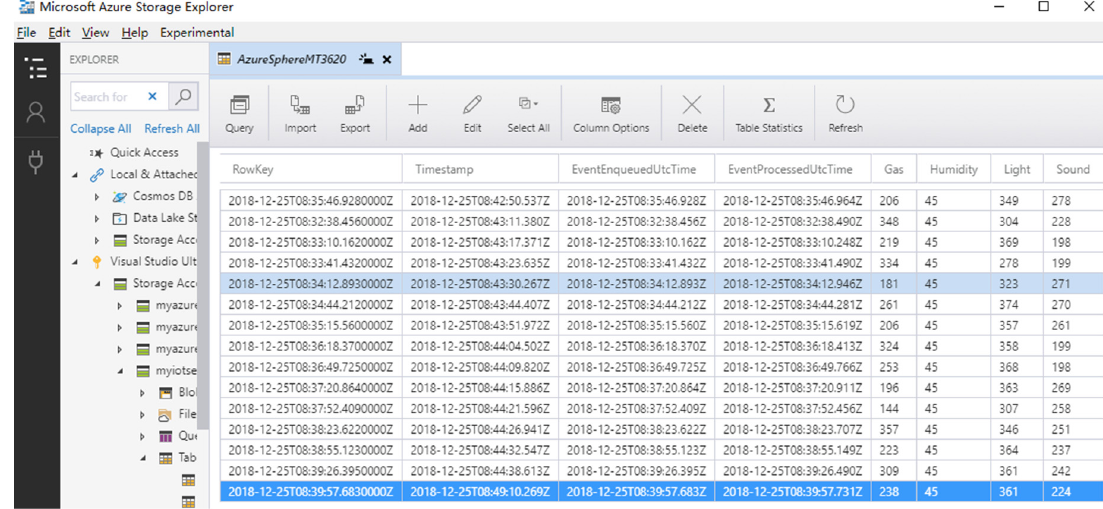
Figure 13. Dataset in Azure Table Storage.